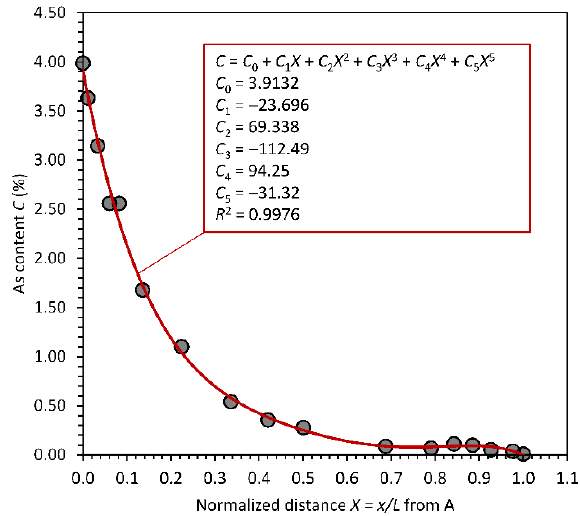
Figure 3. As content variation in sample S in Figure 1 as a function of the normalized distance from the radiation ‐ receiving electrode. The best polynomial (fifth order) is also shown (Data extracted from [4], normalized and reanalyzed to plot the As content from the radiation ‐ receiving side).